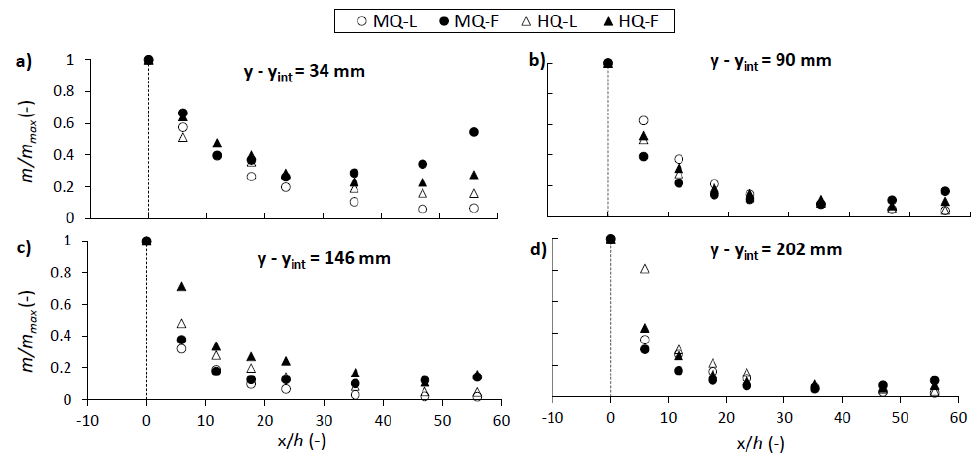
Figure 12. Longitudinal profiles of mean net deposition m in the vegetated area consisting of foliated (F) and leafless (L) flexible plants normalized with the maximum net deposition m max for four lateral positions with increasing distance from the interface at: ( a ) d y = ( y − y int ) = 34 mm, ( b ) d y = 90 mm, ( c ) d y = 146 mm, and ( d ) d y = 202 mm. The dashed line indicates the leading edge of the vegetation at x / h = 0. MQ = medium flow rate (50 L / s); HQ = high flow rate (83 L / s); L = leafless; F = foliated.